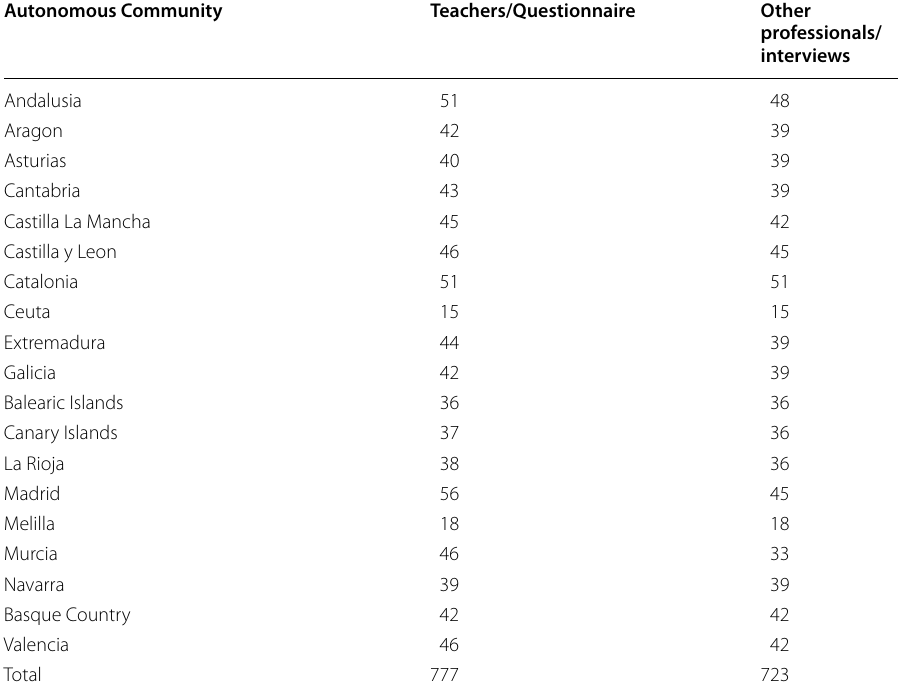
Table 1 Distribution of teaching staff and other professionals by region and type of data collection